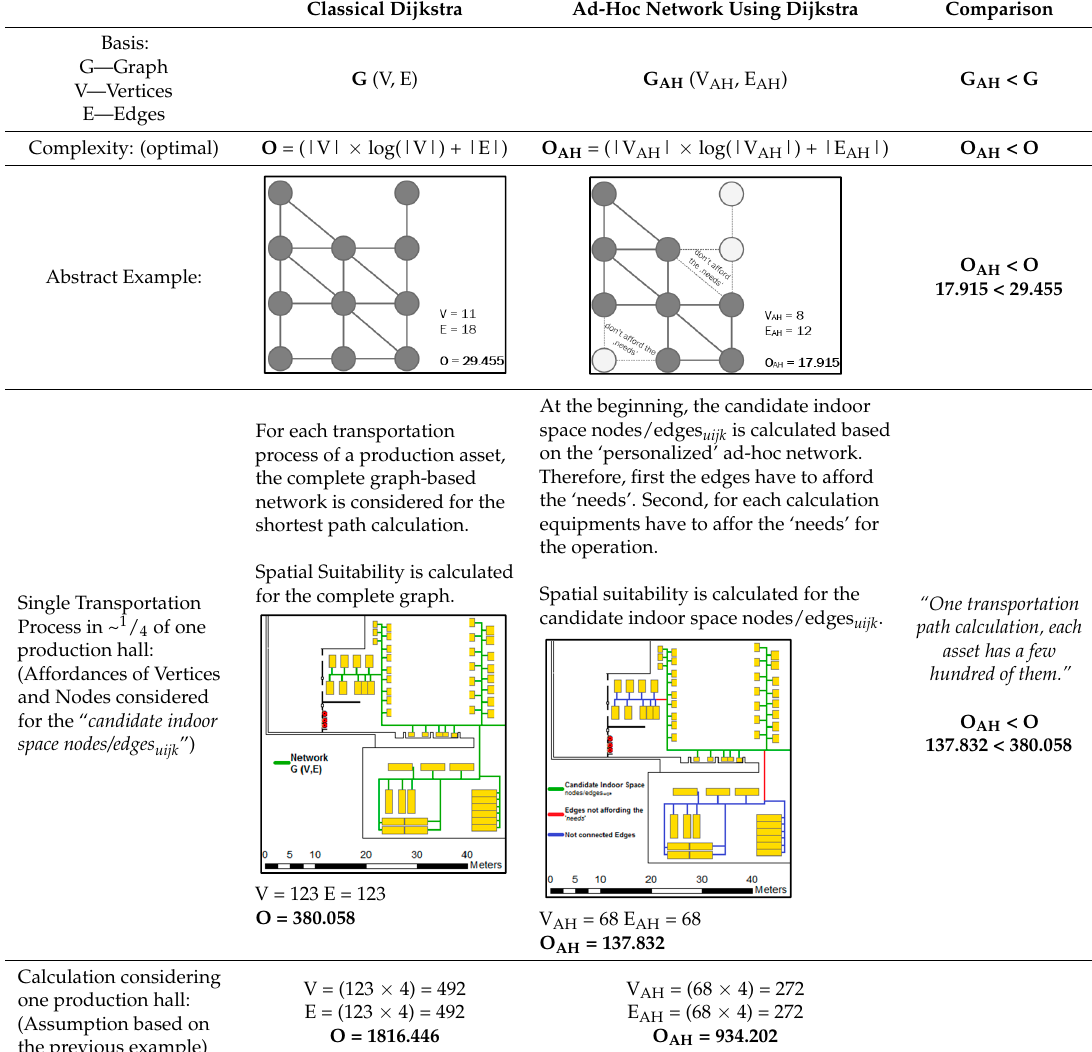
Table 1. Comparison of a classical Dijkstra shortest path algorithm and the Ad-Hoc Suitability Network Algorithm to identify optimal indoor transportation. Classical Dijkstra Ad-Hoc Network Using Dijkstra Comparison